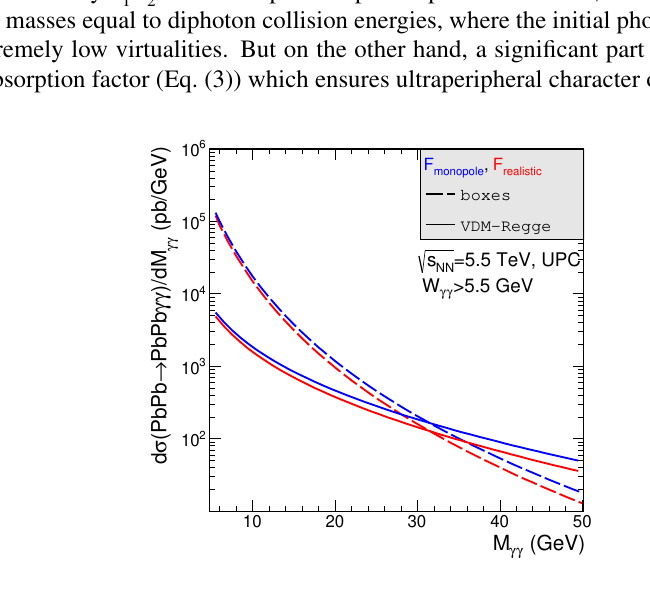
Figure 5. Di ff erentail cross section as a function of diphoton invariant mass. Blue lines - nuclear calculations include the monopole form factor. Red lines - results with the realistic form factor. Solid lines - boxes contribution and dashed lines relates to VDM-Regge